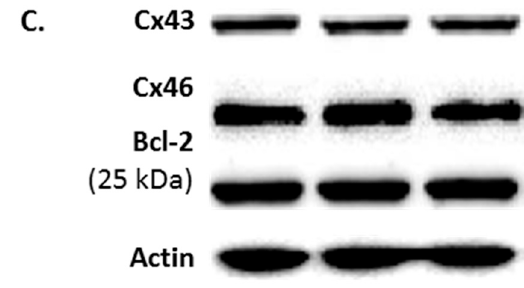
Figure 2. A phenotypic profile of FMC2u cells. Western blot analysis of three different samples of FMC2u (#1–3). ( A ) Images of the epithelial markers E -cadherin, occludin, and claudin-1; ( B ) expression of estrogen receptor (ER α and ER β ), progesterone receptor (PR), and human epidermal growth factor receptor 2 (HER2); and ( C ) expression of gap junction proteins (connexin 43 and 46) and molecular marker Bcl-2 are shown using antibodies against specific protein. Actin used as a loading control.